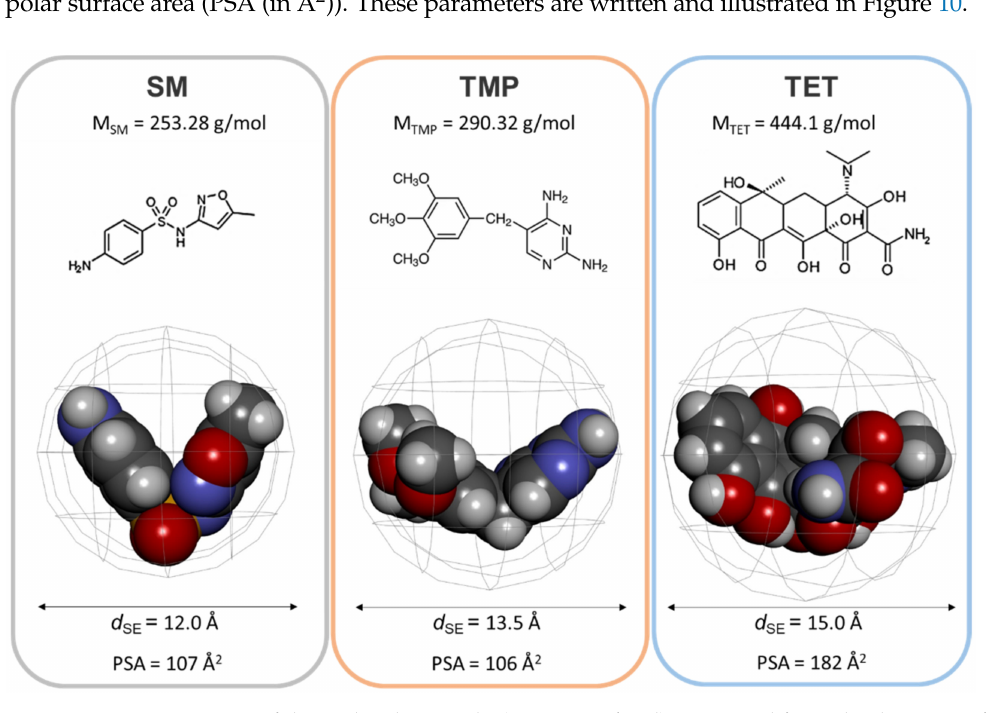
Figure 10. A comparison of the molecular weight (M ATB in g/mol), structural formula, diameter of the spherical enclosure ( d SE in Å), and polar surface area (PSA in Å 2 ) for SM, TMP, and